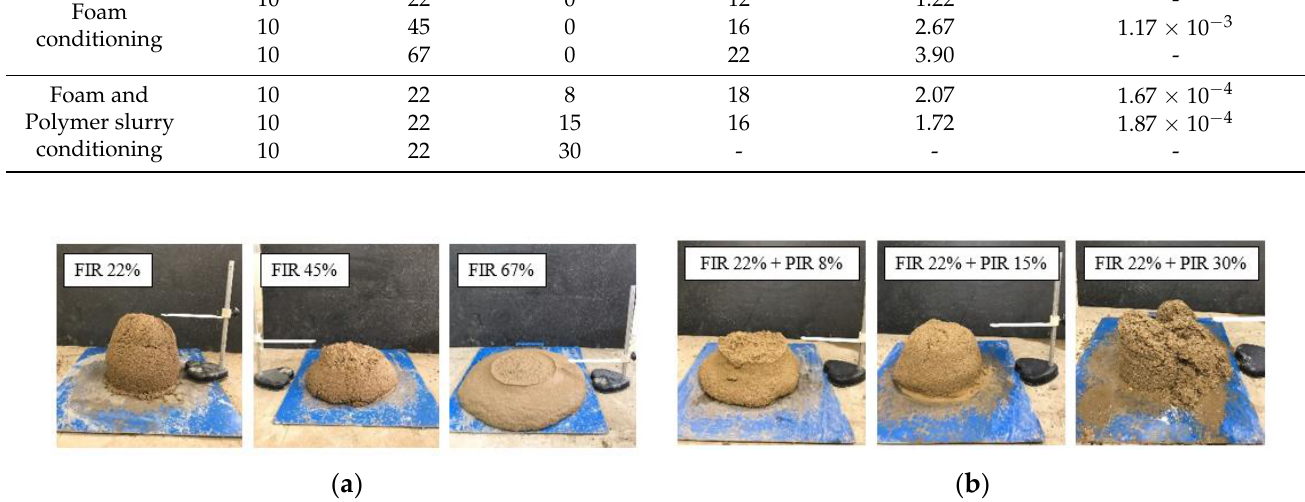
Figure 9. Slump test results depending on added conditioning agents: ( a ) Foam conditioning only, ( b ) Foam and polymer slurry conditioning.